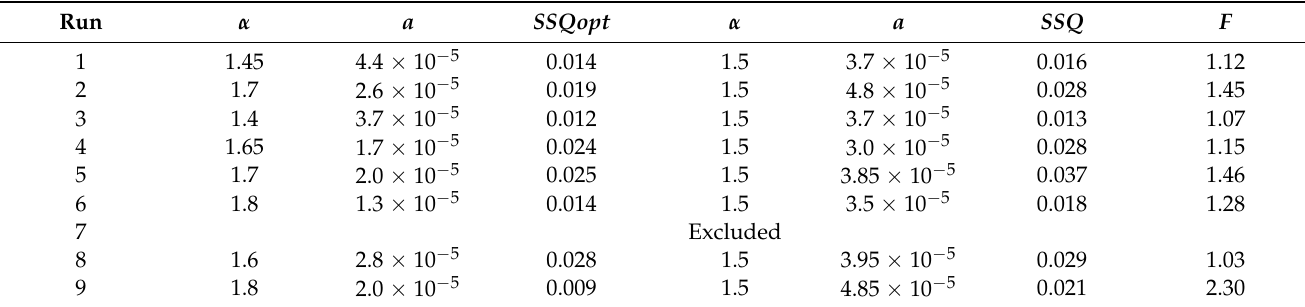
Table 5. The “F-Test” results for Runs 1 to